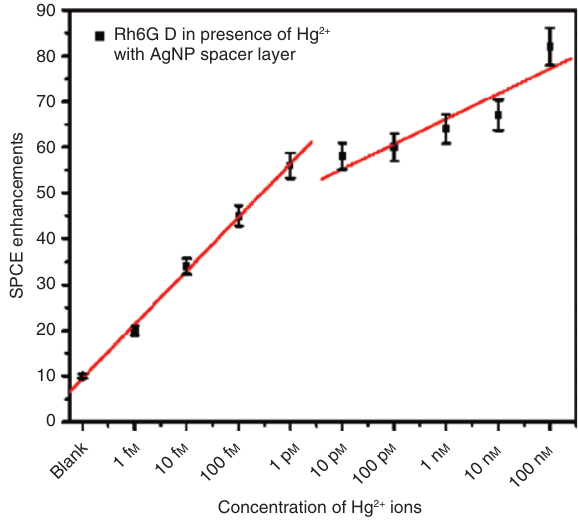
Figure 4: Concentration plot indicating AgNP spacer layer-depend- ent SPCE enhancements for different Hg 2 + concentrations.